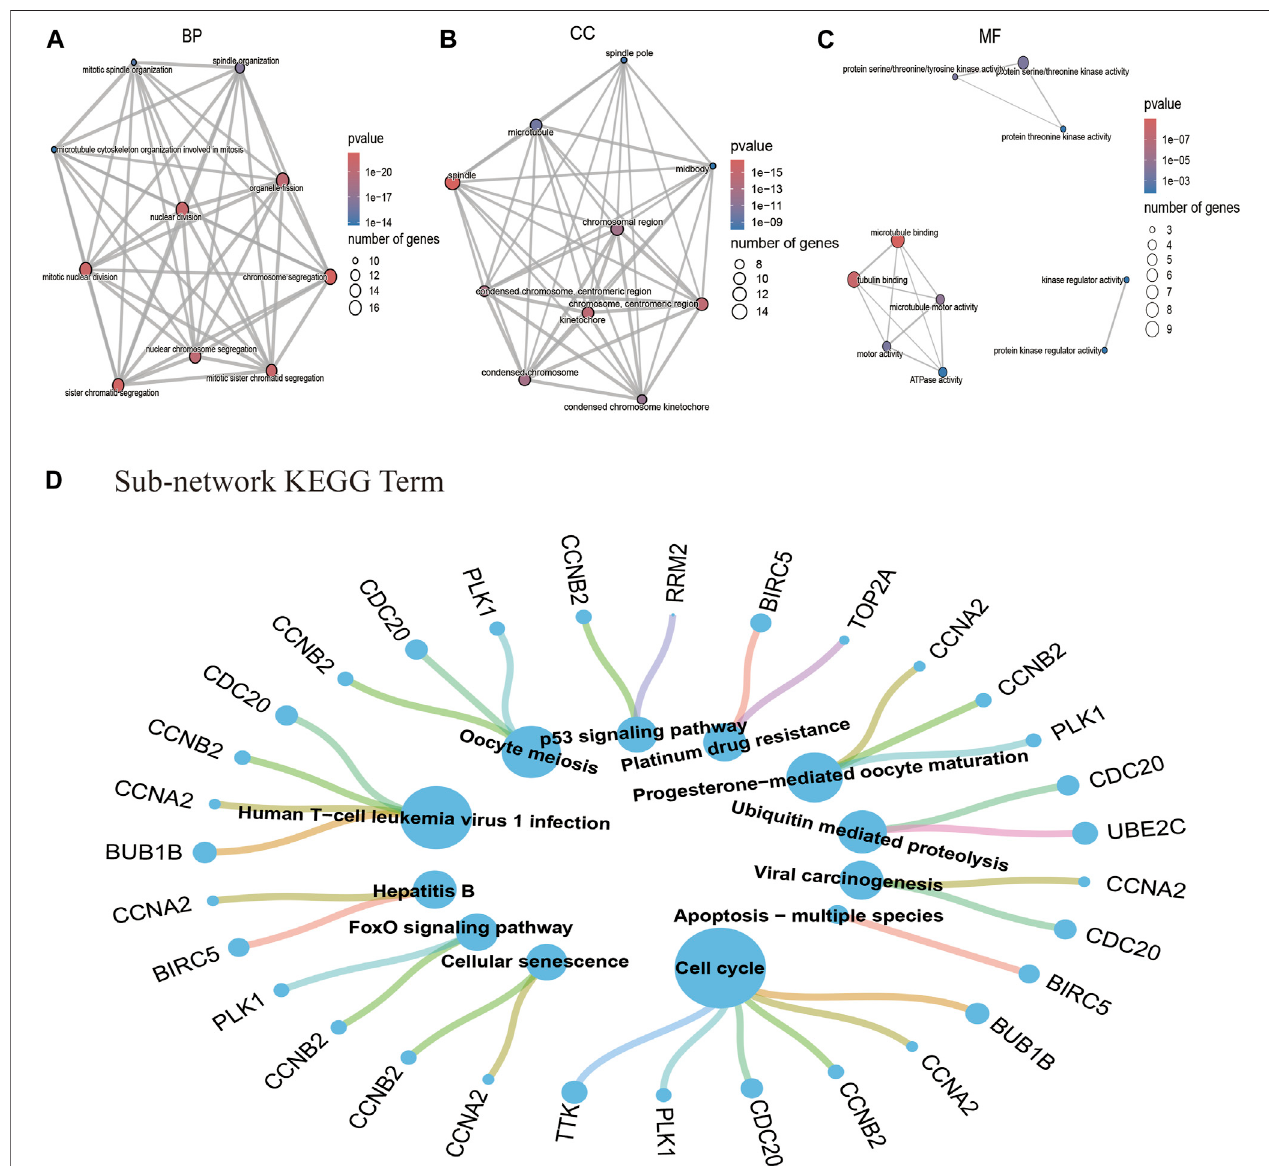
FIGURE 6 | GO and KEGG pathway analysis based on the interactional genes in the biggest sub-network. (A) Top 10 BP terms of GO analysis. (B) Top 10 CC termsofGOanalysis. (C) Top10MFtermsofGOanalysis. (D) TwelvepathwaytermsofKEGGanalysis.Note:nodesrepresentgenesorpathways,andedgesrepresent enrichment relationships. The size of term nodes is positively correlated with the number of enriched genes. The size of gene nodes is positively correlated with the number of enriched terms.